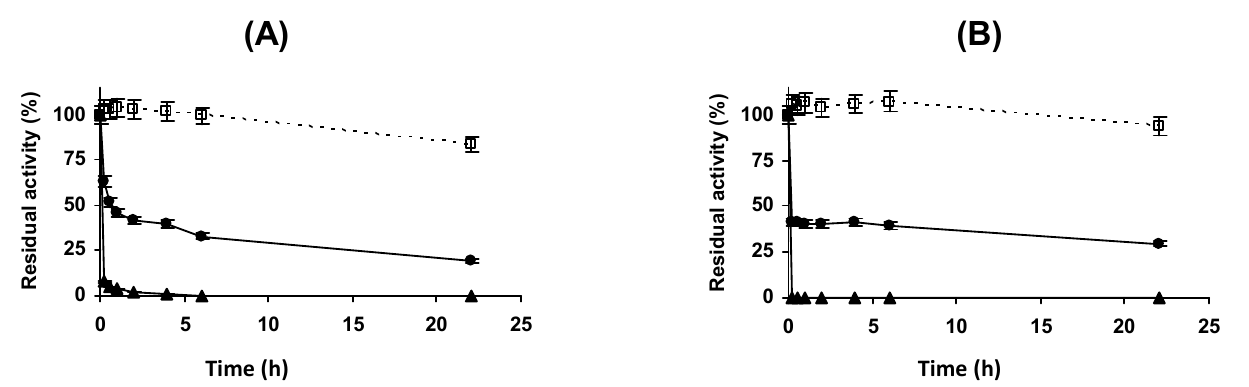
Figure 6. Effect of the pH on the r Aae UPO immobilization on amino-glutaraldehyde support. The immobilization was performed at 25 °C and ( A ) pH 5.0, ( B ) pH 7.0. Other details can be found in the Methods section. Full circles: suspension; full triangles: supernatant; empty squares with dotted line: reference.